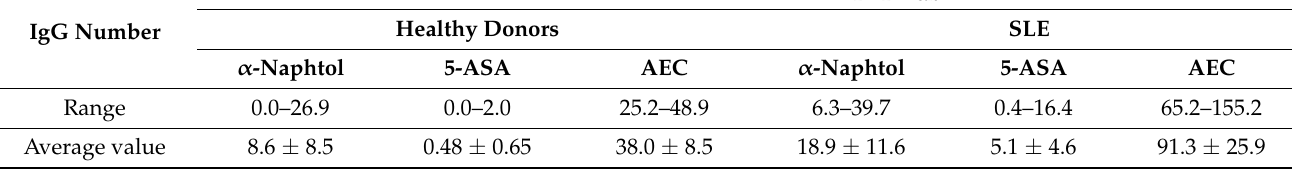
Table 2. The apparent k cat values characterizing peroxidase activity of individual IgGs from the sera of healthy donors, patients with SLE in the oxidation of α -naphtol, 5-ASA, and AEC [188]